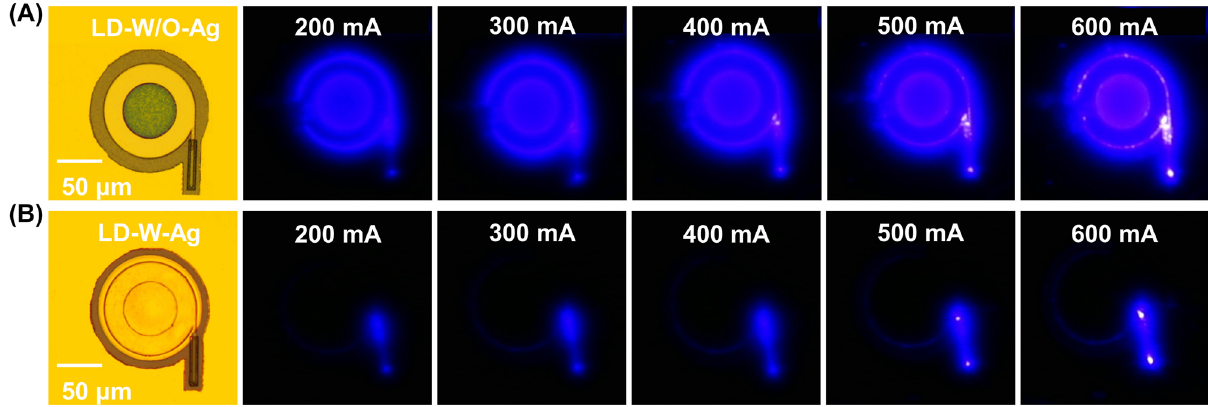
Figure 2: Top-view optical microscope and luminous images of GaN-on-Si microring lasers ( R = 50 μ m, r = 30 μ m) at various pulse injection currents. (A) LD-W/O-Ag, and the left part of the emission patteren was blocked by the electrical probe. (B) LD-W-Ag. There were two emission points on the direct-coupled waveguide corresponding to points #1 and #2 in Figure 1(C) and (D), respectively. For the emission from point #1, it was mainly due to the height difference between microring and coupled waveguide caused by removing the metal on the waveguide.